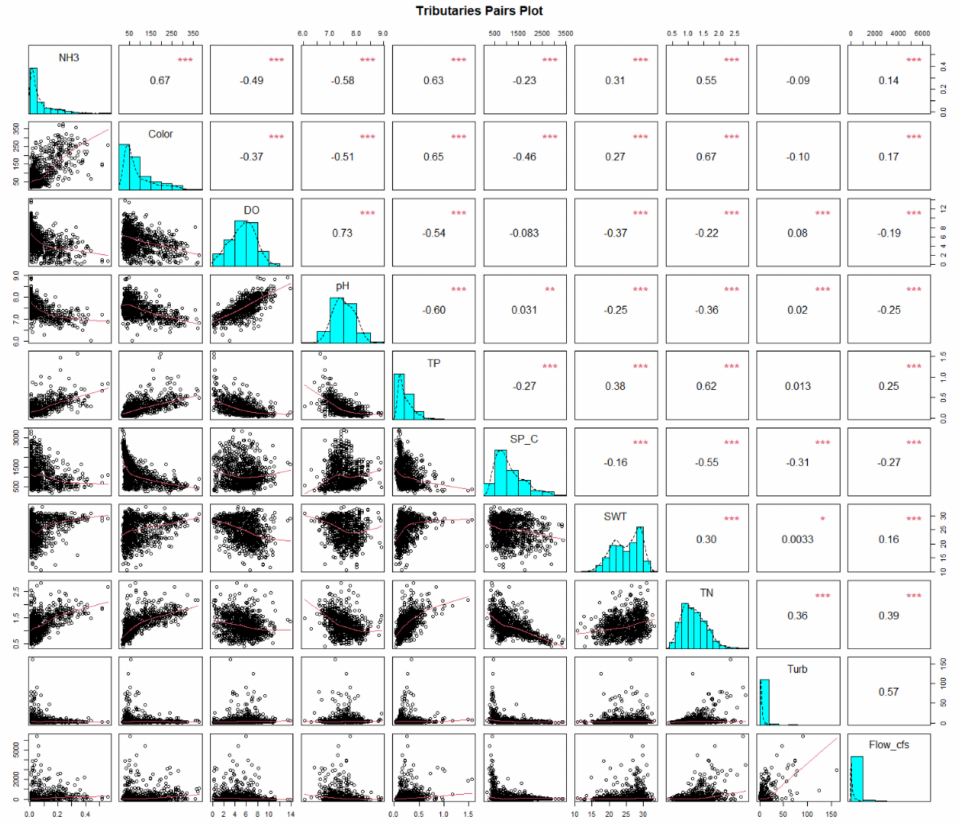
Figure 5. Pairs plot displaying Kendall’s tau correlation coefficient and p -value between water quality variables from 1999 to 2019. Central diagonal: variable names and histograms with a density line. Upper right half: Kendall’s tau correlation coefficient and p -value. Lower left half: scatter plots with loess smoothing. For *** p < 0.001, ** p < 0.01, * p <